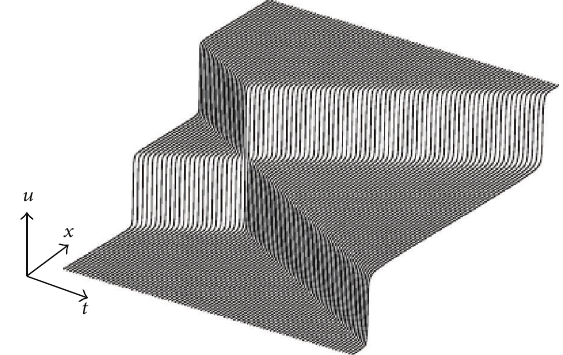
Figure 1: Evolution of the kink-kink pair, 𝑉 1 > 0 , 𝑉 2 < 0 .